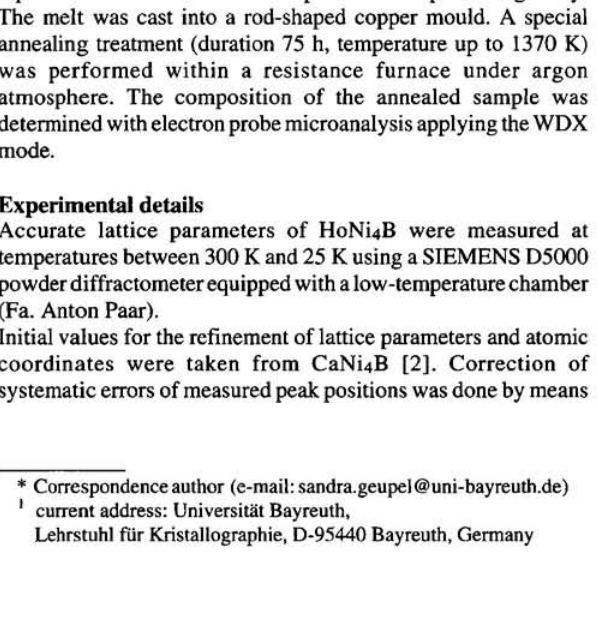
Table 1. Data collection and handling.